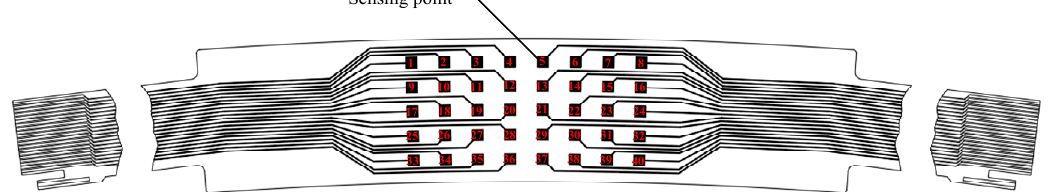
Figure 11. Sketch diagram of the PVDF sensor array.